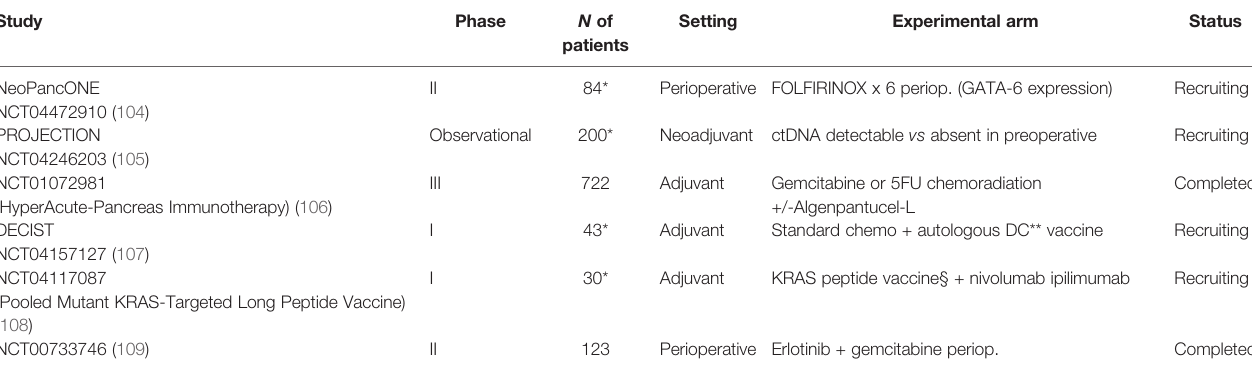
TABLE 3 | Selected major ongoing studies investigating new perioperative/adjuvant approaches